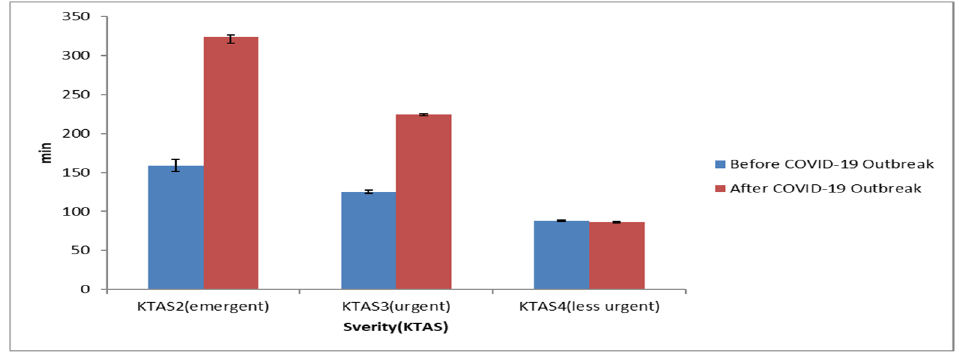
Figure 1. The difference in the emergency department length of stay (EDLOS) by severity before and after COVID-19 outbreak.